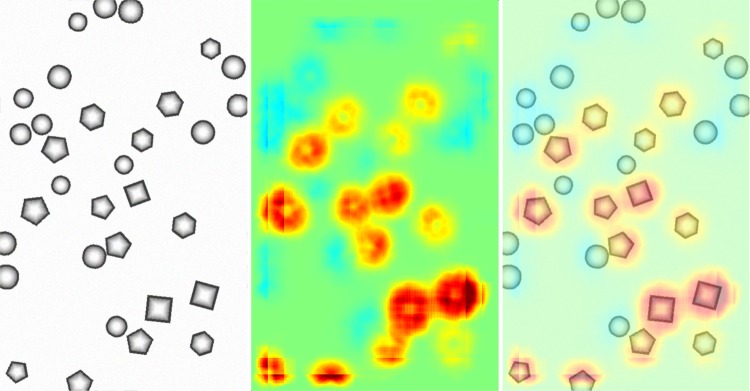
Pixel-wise decomposition for Bag of Words features over χ
2-kernels using the Taylor-type decomposition for the third layer and the layer-wise relevance propagation for the subsequent layers.Left: The original image. Middle: Pixel-wise prediction. Right: Superposition of the original image and the pixel-wise prediction. The decompositions were computed on tiles of size 102 × 102 and having a regular offset of 34 pixels. The decompositions from the overlapping tiles were averaged. In the heatmap, based on linearly mapping the interval [−1, +1] to the jet color map available in many visualization packages, green corresponds to scores close to zero, yellow and red to positive scores and blue color to negative scores. See text for interpretation.